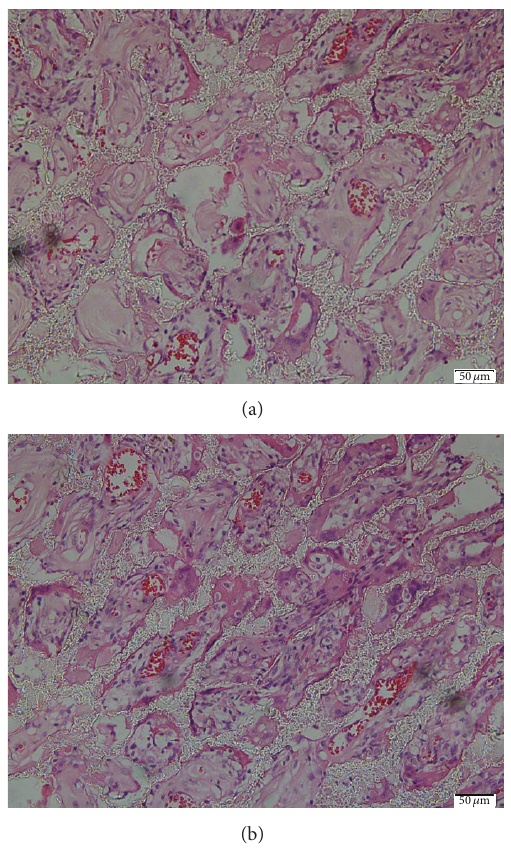
Figure 5: HE staining of specimens (magnification × 100): the vascular walls and red blood cells can be seen in both groups 10 weeks after implantation: (a) from group A; (b) from group